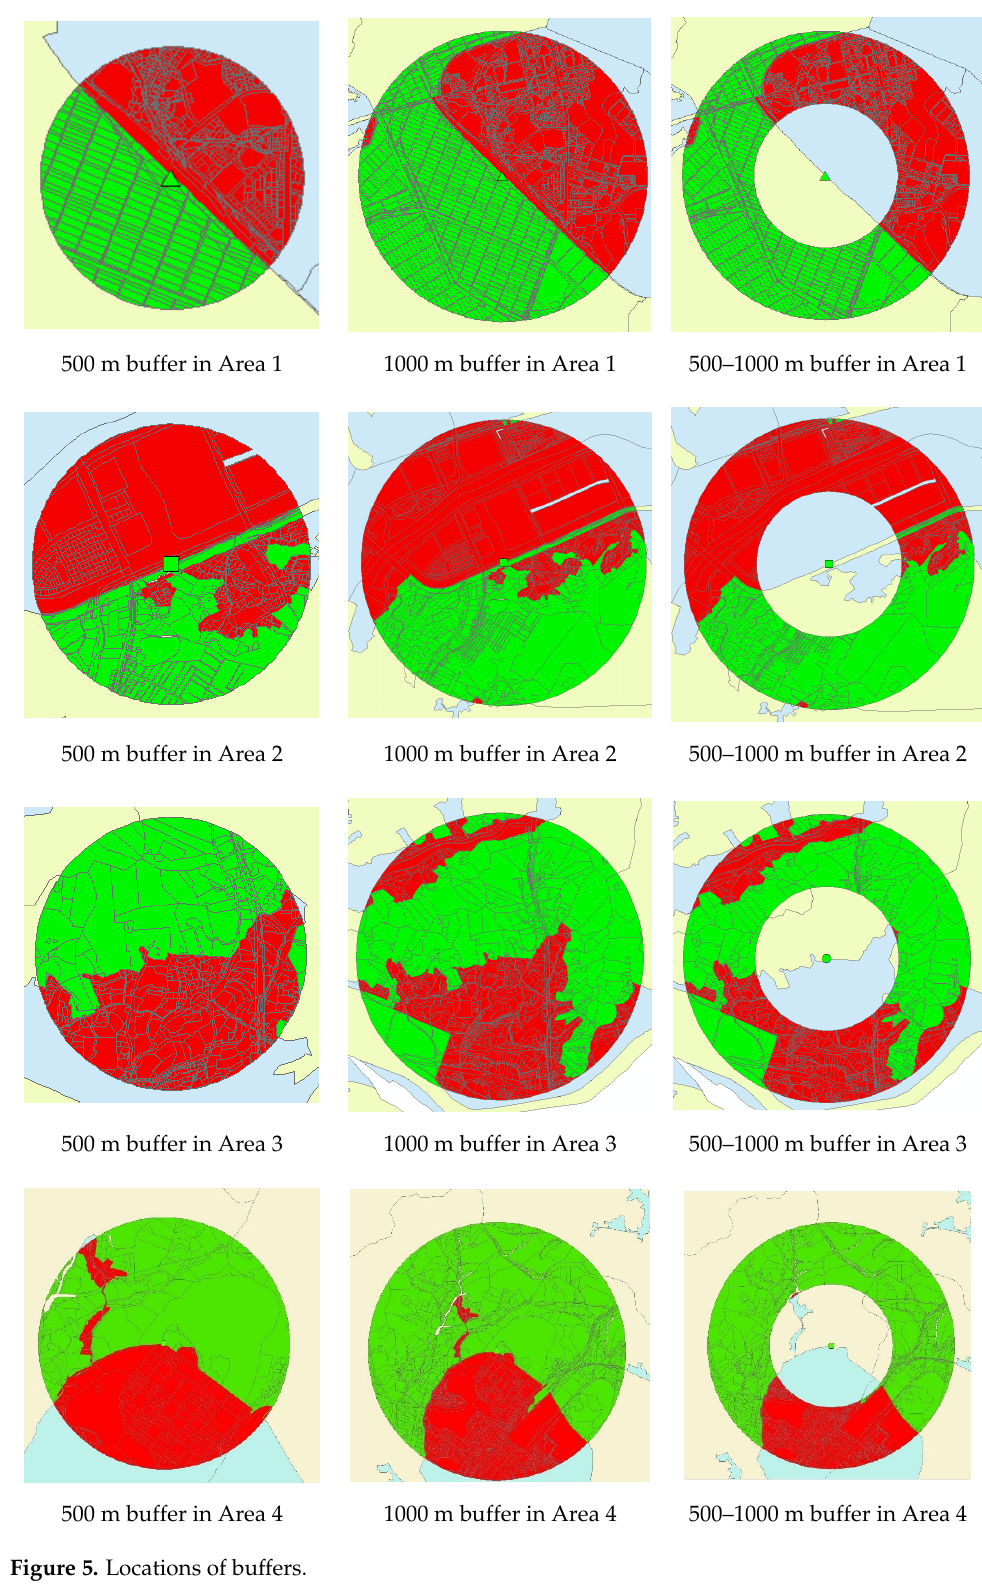
Figure 5. Locations of buffers.